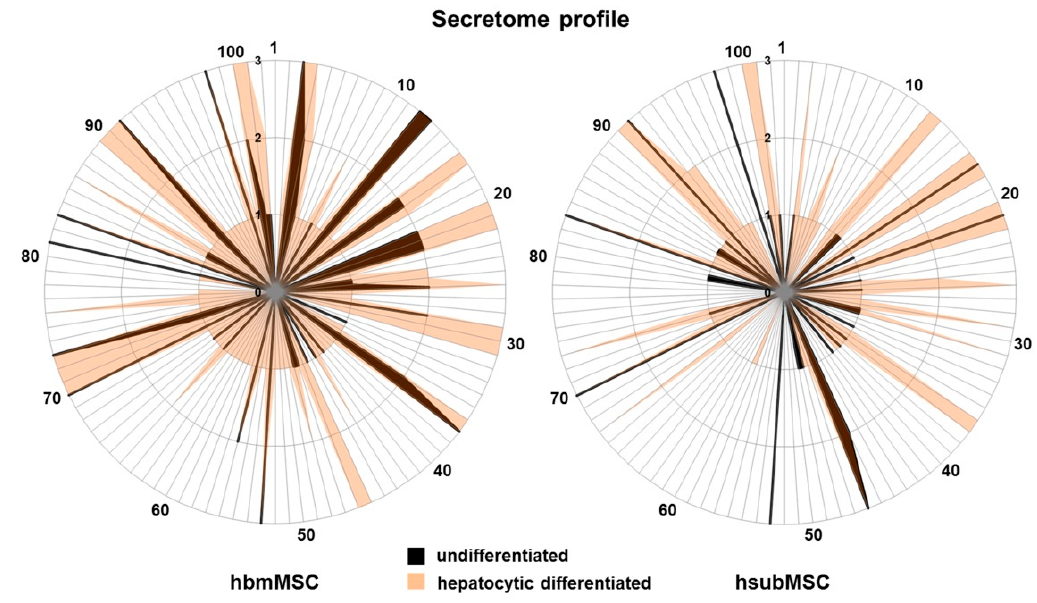
Figure 4. Graphical nets of proteins secreted by undifferentiated ( black lines) and differentiated ( orange lines) hbmMSC ( left ) and hsubMSC ( right ) in low (1), medium (2) and high (3) abundance as taken from results shown in Figure 3. Individual proteins are numbered consecutively from 1 to 102 as shown at the edge of the radii. A comprehensive list of numbers and corresponding proteins is given in Table S5.